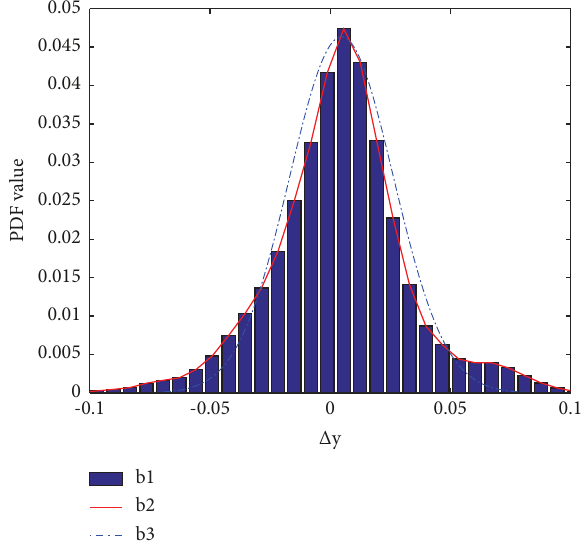
Figure 4: PDF of Monte Carlo simulation